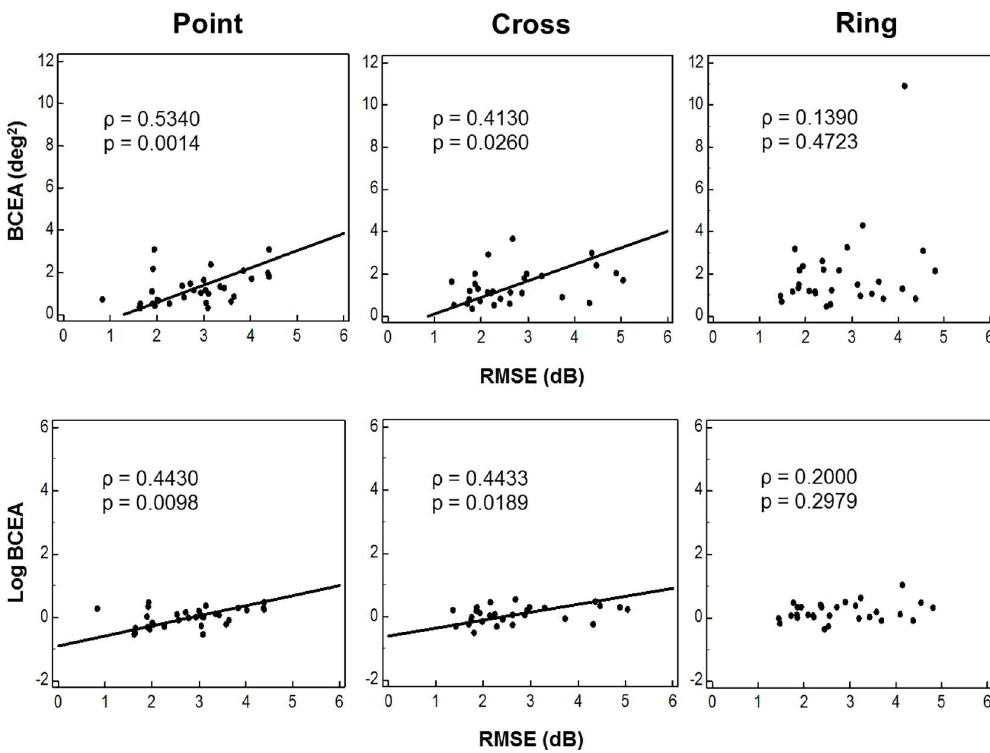
Fig 4. Relationship between Fixation Behavior and Threshold Sensitivity. (Top) Scatter plots of the relationshipbetweenthe root mean square error (RMSE) at each test point and the bivariate contour ellipsearea (BCEA). (Bottom) The relationshipbetweenRMSE and log(BCEA). Correlation coefficients ( ρ ) were calculatedwith Spearman’srank